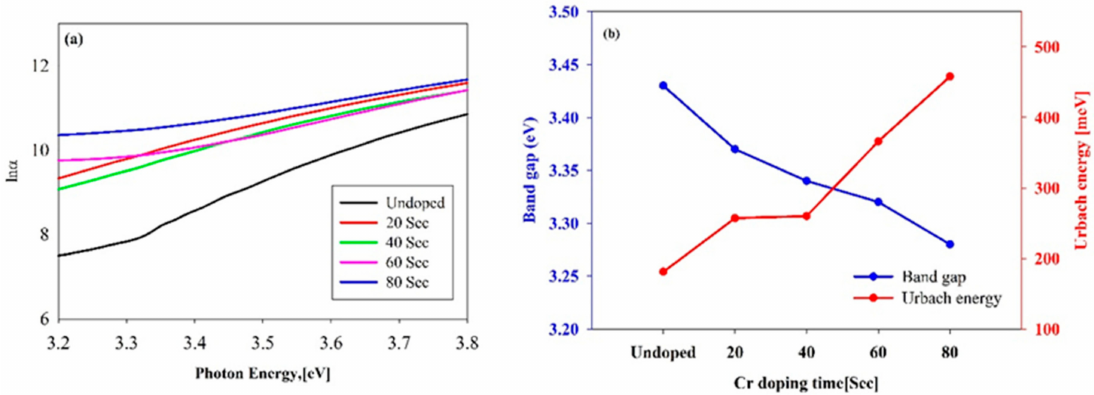
Figure 5. ( a ) Urbach tail and ( b ) bandgap versus Urbach energy of the Cr-doped NiO at different doping